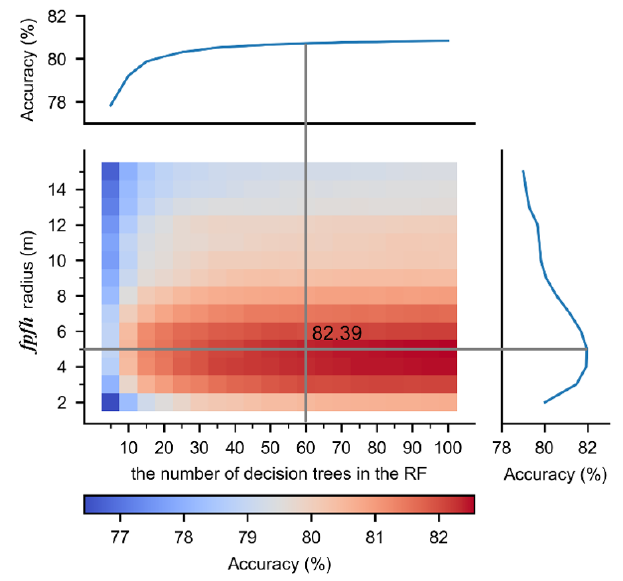
Figure 12. Effect of FPFH radius and the number of decision trees on the accuracy of RF in the proposed method.